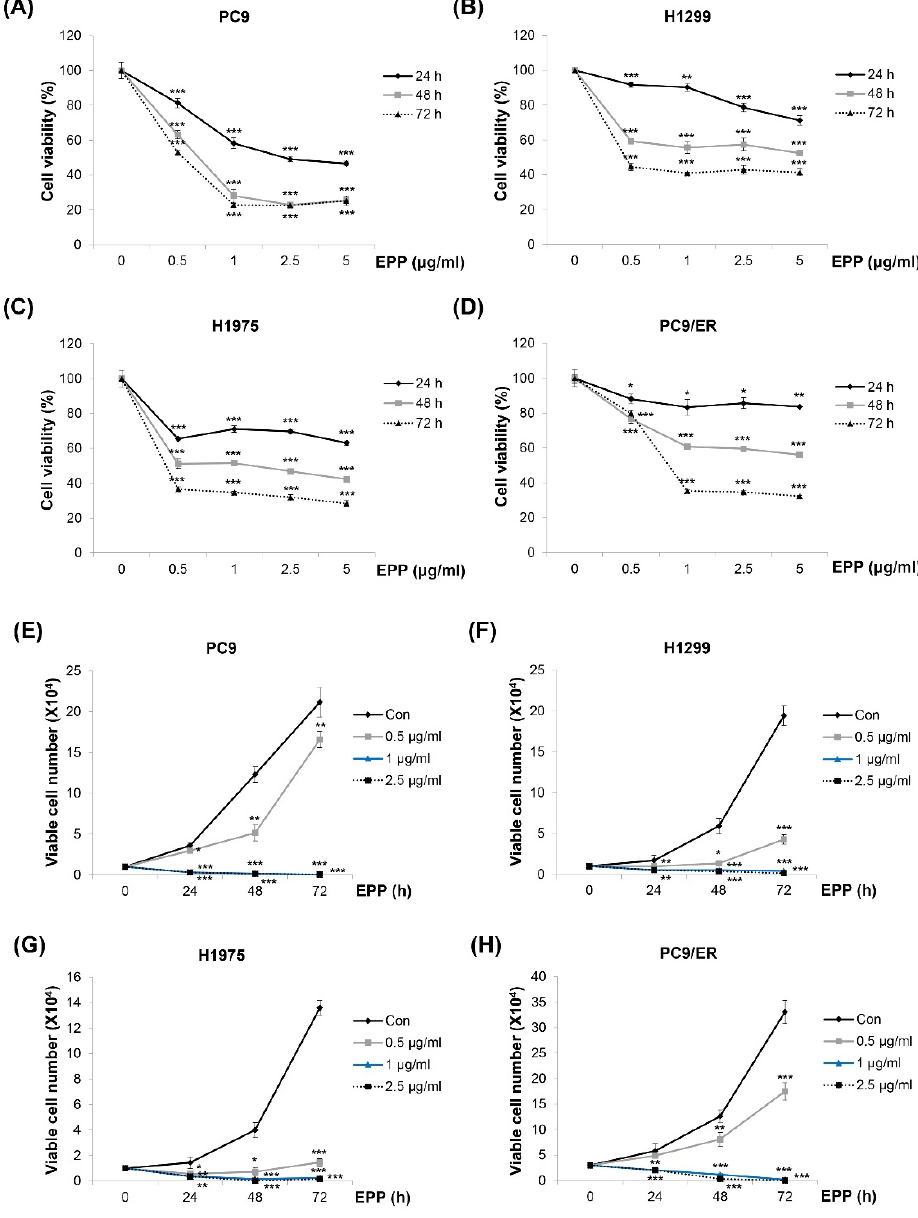
Figure 1. Effect of EPP on the growth of human NSCLC cell lines with different EGFR mutation statuses. ( A – D ) PC9 ( EGFR Glu746-Ala750 deletion mutation in exon 19; EGFR TKI-sensitive, ( A )),